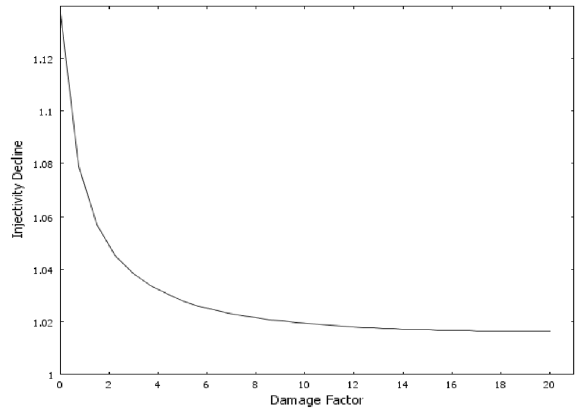
Fig. 22 Injectivity decline with time